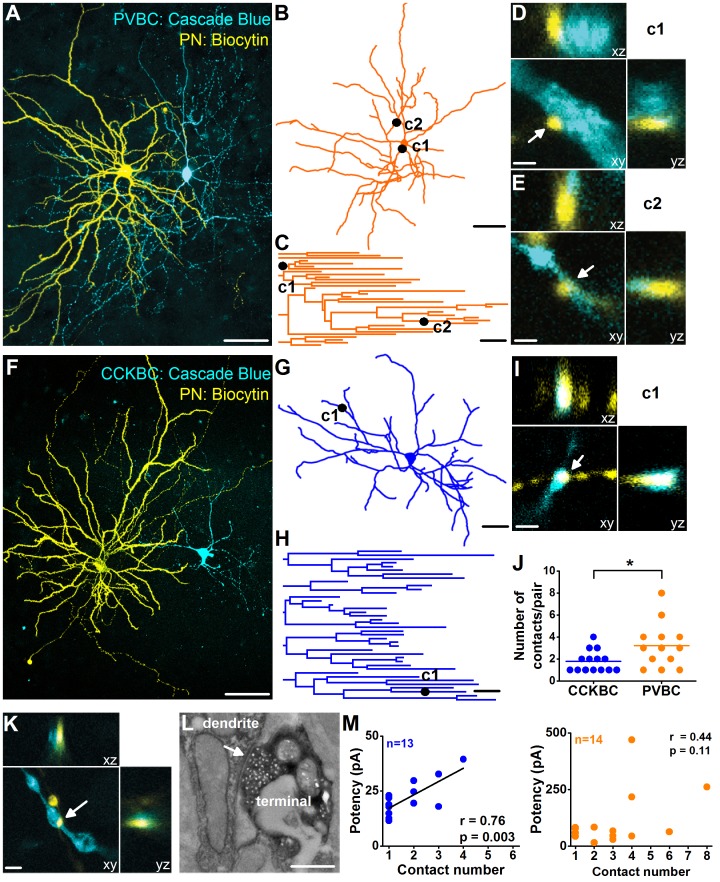
Principal neurons PNs innervate the 2 basket cell (BC) types differently.Maximum z intensity projection image of a representative PN→parvalbumin-containing basket cell (PVBC) pair (A) and a PN→cholecystokinin-expressing basket cells (CCKBC) pair (F). Cascade Blue was used to label the BCs, while biocytin was introduced into the PNs to visualize them with streptavidin-conjugated Alexa647. Scales for (A and F): 50 μm. Neurolucida reconstructions (B and G) and the resulted dendrogram analysis (C and H) of the PVBC and CCKBC shown in (A) and in (F), respectively, marking the location of connections 1 and 2 (c1 and c2) established by the monosynaptically connected presynaptic PNs. Scales for (B, C, G, H): 50 μm. (D and E) High-power magnification 3D confocal images of putative contacts c1 and c2, showing close appositions between the dendrite-targeting boutons of the PN (yellow) and the PVBC dendrites (blue). Scale: 2 μm. (I) High power magnification 3D confocal images of a putative contact c1, showing close appositions between the bouton of the PN (yellow) and the CCKBC dendrites (blue). Scales: 2 μm. (J) PNs establish significantly more contacts on PVBCs than on CCKBCs (1.79 ± 0.26, n = 14 PN→CCKBC pairs, 3.23 ± 0.57, n = 13 PN→PVBC pairs, Mann–Whitney U test, *p < 0.05) (S7 Data). Each data point on the plot was obtained from a pair recording, and lines represent means. (K) 3D confocal image showing a close apposition between a biocytin-labeled PN terminal (yellow) and a Cascade Blue-labeled BC dendrite (blue). Scale: 2 μm. (L) Electron microscopic analysis of the contact shown in (K) confirmed the presence of the synaptic junction (arrow). Scale: 500 nm. (M) A strong relationship was found between the number of contact sites and the unitary excitatory postsynaptic current (uEPSC) potency in the case of PN→CCKBC pairs, while no correlation could be observed in the case of PN→PVBC pairs (S7 Data).